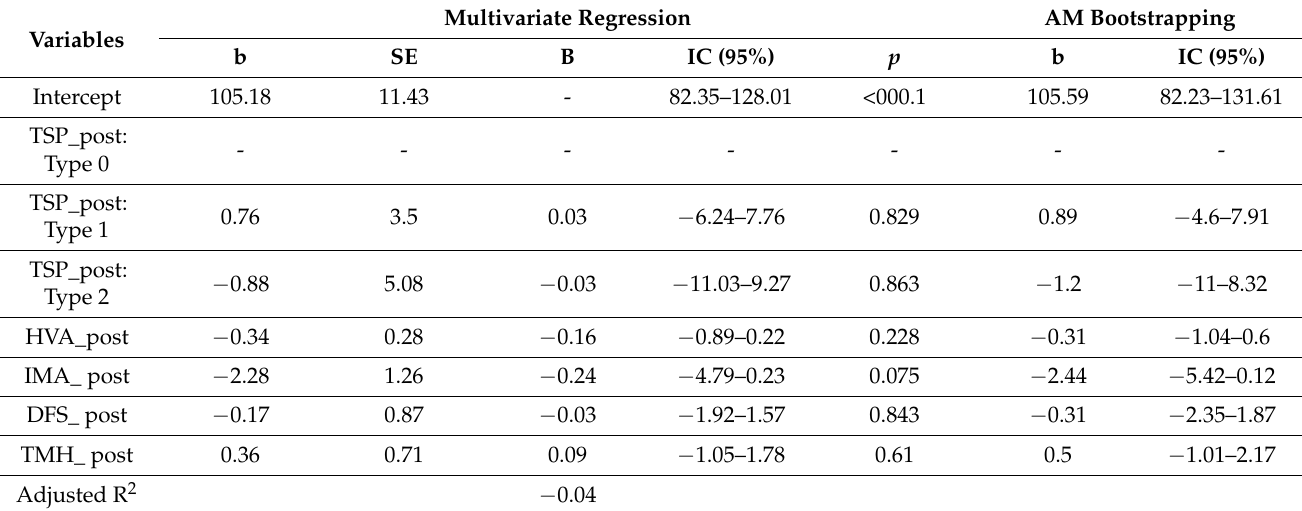
Table 4. Multivariate regression analysis of postoperative AOFAS values with the postoperative radiological measures. Pre: Preoperative values. DFS: Distance of the fibular sesamoid bone to the second metatarsal axis. TMH: Translation of the first distal metatarsal head. HVA: Hallux valgus angle. IMA: I–II intermetatarsal angle. TSP : Tibial Sesamoid Position. AOFAS: American Orthopaedic Foot and Ankle Society